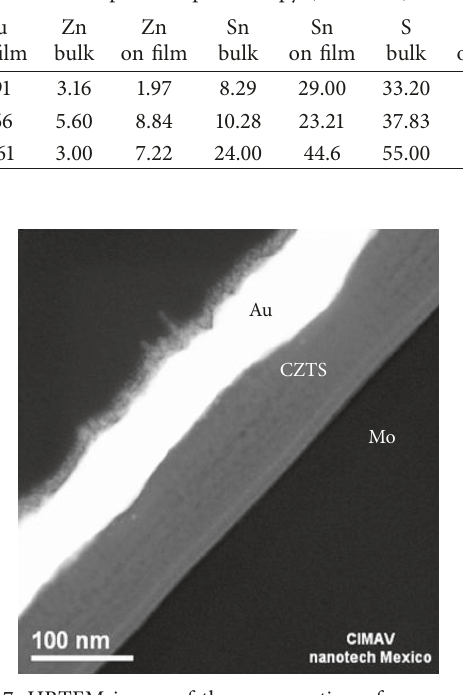
Figure 5: Scheme describing the effect of PVP on particle formation during the synthesis process of CZTS from left to right: precursors are shown; then in the box, the PVP as a variable introduced in the experiment; the process; and the different results in morphology. Table 1: XRD diffraction study and EDS analysis of the CZTS synthesized with different PVP contents. Sample X-ray diffraction crystallite size (nm)